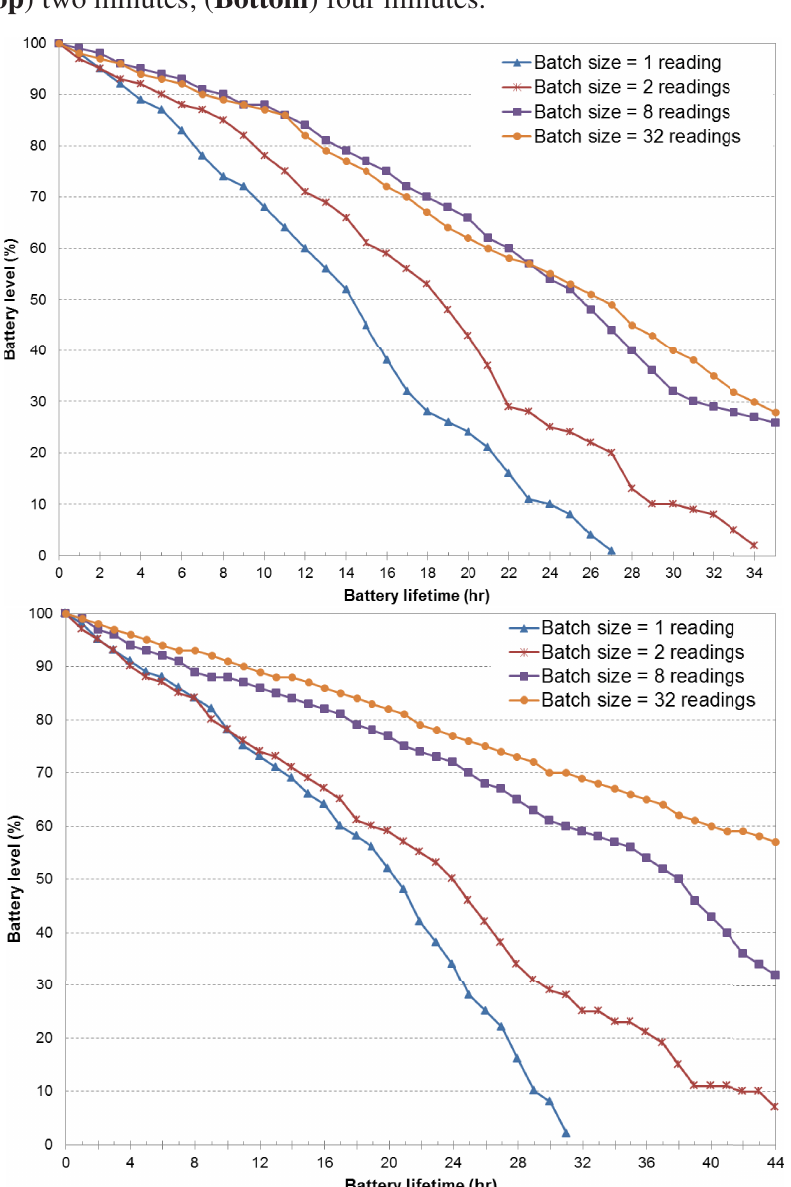
Figure 4. Battery lifetime of four batch transmission schemes under different fixed sensing intervals: ( Top ) two minutes; ( Bottom ) four